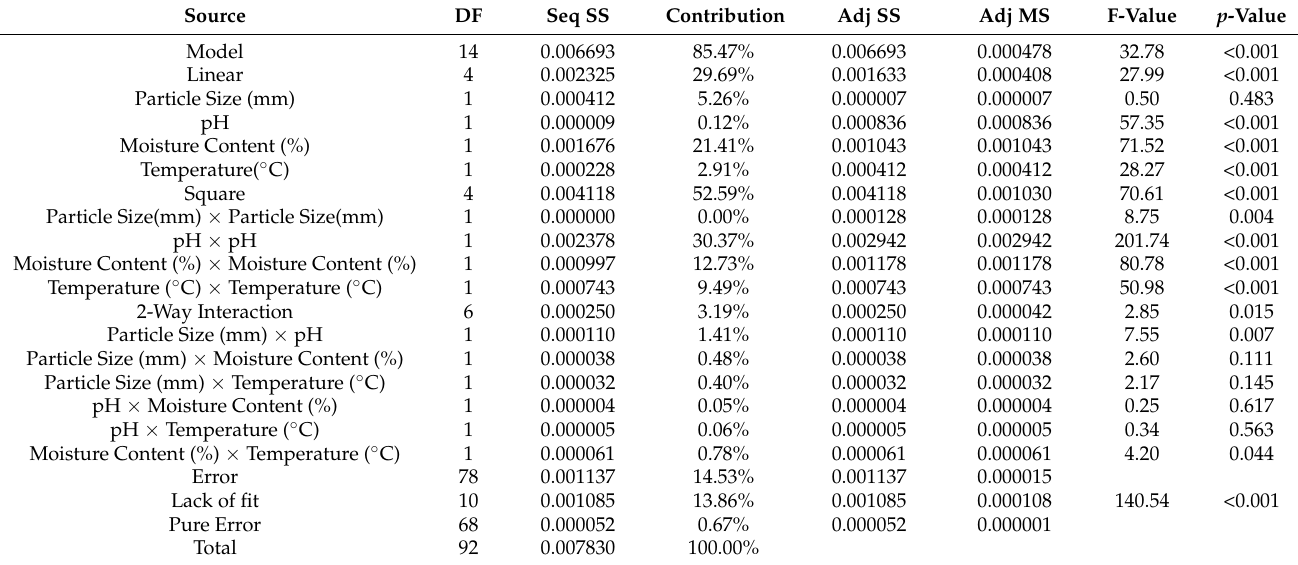
Table 3. ANOVA table for